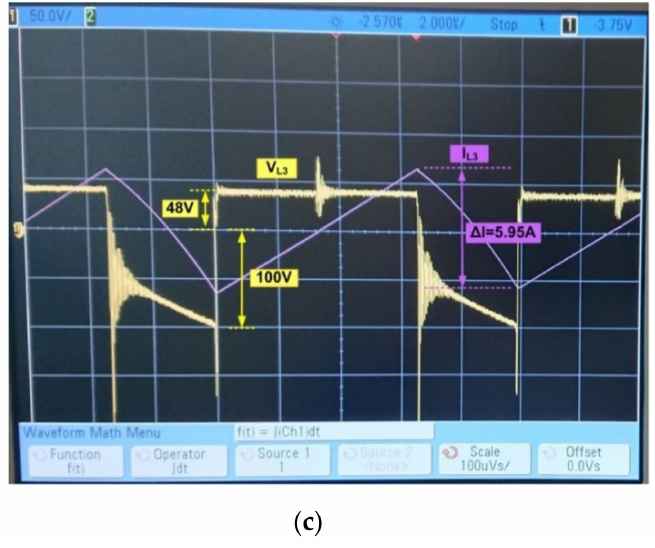
Figure 12. Experimental results: ( a ) V L 1 and I L 1 , input voltage V in 1 = 12 V, ( b ) V L 2 and I L 2 , input voltage V in 2 = 24 V, ( c ) V L 3 and I L 3 , input voltage V in 2 = 48 V. According to Equation (15), and using the input voltages and currents, the efficiency obtained is η = 90.51%. Figure 13 shows the experimental set up: (a) three-input step-up converter, (b) three input voltage sources, (c) the PWM signal generator and (d) the 33 Ω output load.